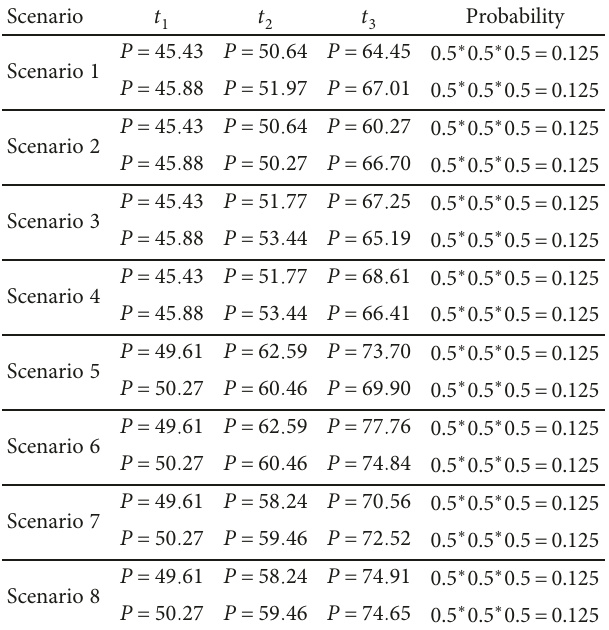
Table 3: Demand d , for each operating condition and period along 1 the planning horizon.